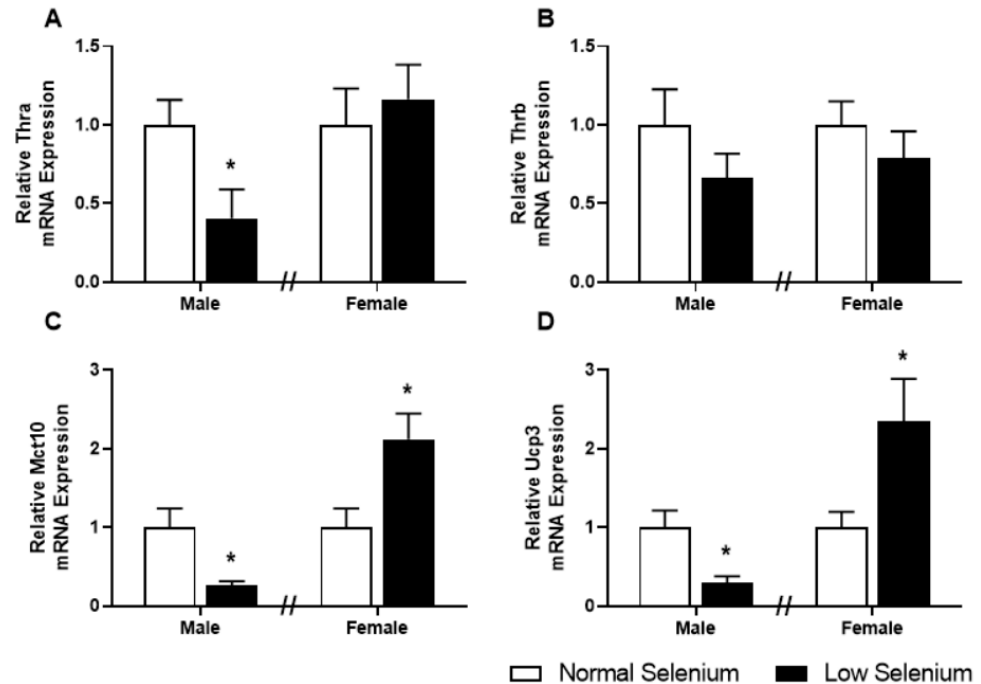
Figure 5. Thyroid hormone transporters and receptors in offspring skeletal muscle. PN180 mRNA expression in the gastrocnemius of thyroid hormone transporters and receptors. Expression of ( A ) ThrA, ( B ) ThrB , ( C ) Mct10 and ( D ) Ucp3 in males and females at PN180. Open bars (white) indicate offspring from litters that consumed a normal selenium diet, whereas closed bars (black) are offspring from litters that consumed a low selenium diet throughout pregnancy and up until weaning. Data are mean ± SEM and were analysed by unpaired t-tests between mice for litters on a normal selenium diet and a low selenium diet in both males and females. * = p < 0.05 compared to control of same sex. n = 6–8.